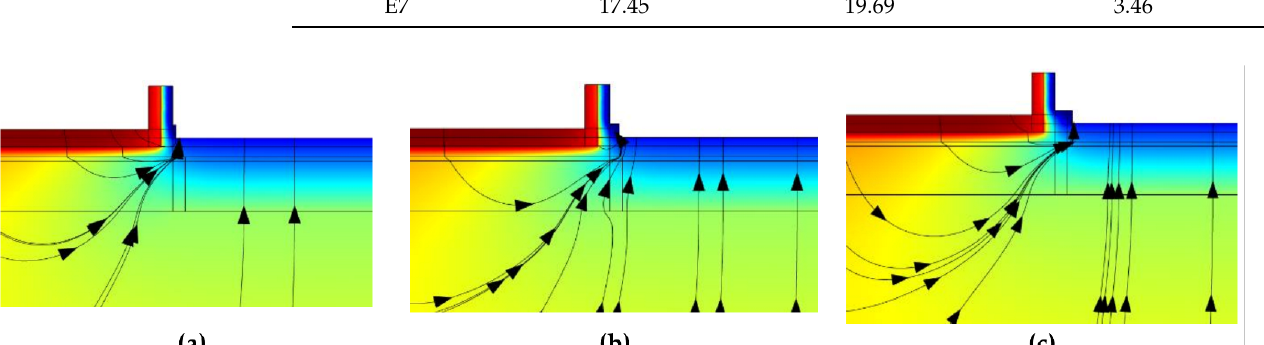
Figure 10. Heat flow density division diagram. ( a ) B1 heat flow direction diagram, ( b ) E4 heat flow direction diagram, ( c ) E7 heat flow direction